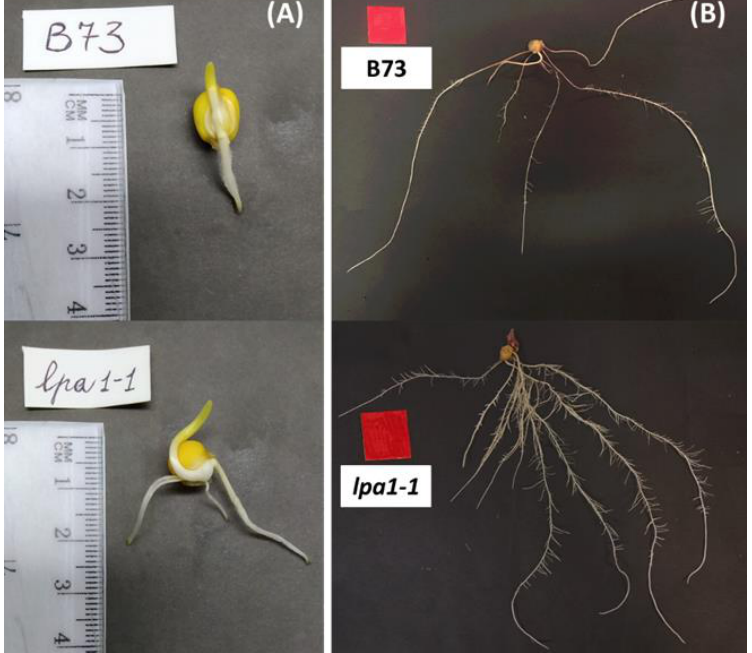
Figure 1. Representative phenotype of wild-type (B73) and lpa1-1 at 5 DAS ( A ) and at 16 DAS, after growing in hydroponic solution ( B ).